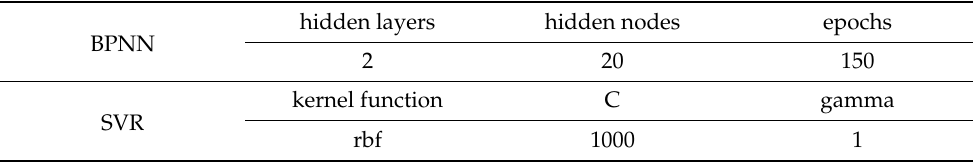
Table 8. Hyperparameters setting for LSTM, BPNN, and SVR.